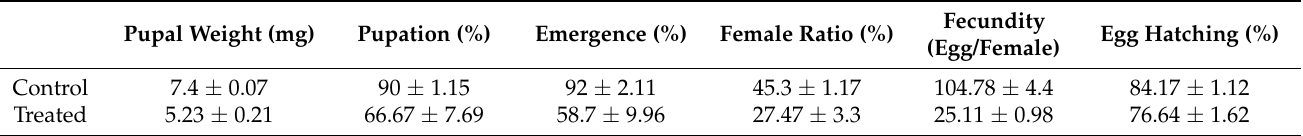
Table 4. Effects of sublethal concentration of farnesyl acetate on pupal weight, pupation rate, adult emergence rate, female ratio, fecundity, and egg hatching rate (mean ± SE). Pupal Weight